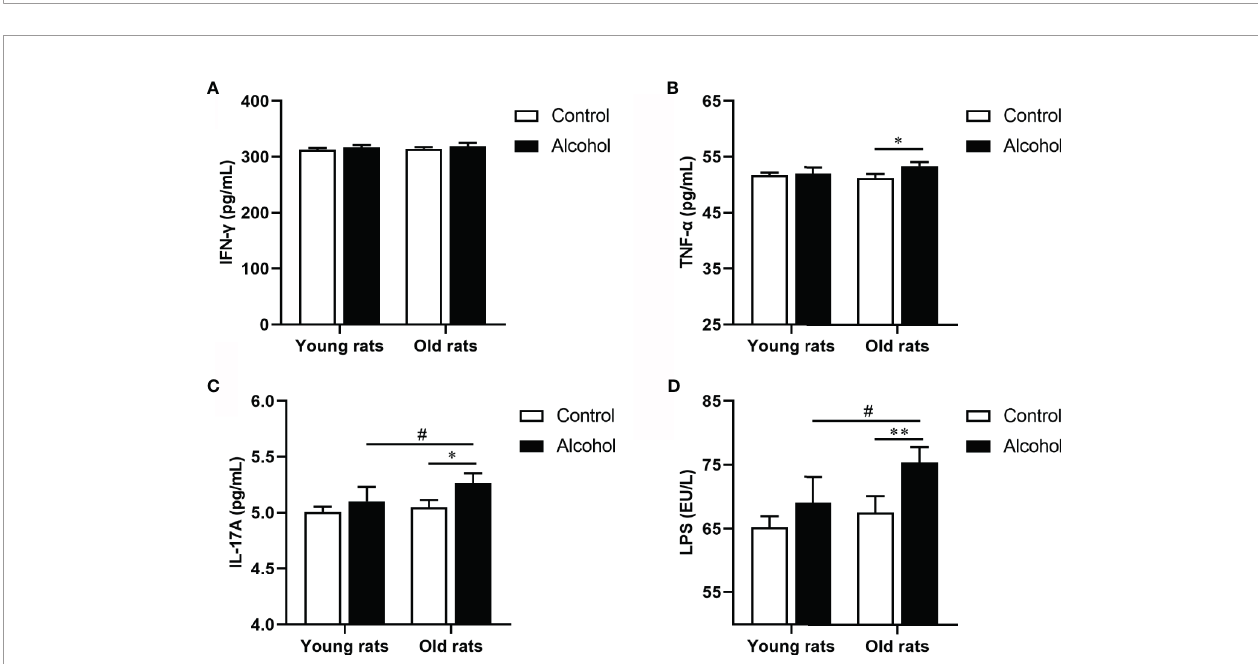
FIGURE 4 | Effects of alcohol on serum in fl ammatory cytokine in young and old rats. (A) The expression of IFN- g in serum; (B) The expression of TNF- a in serum; (C) The expression of IL-17A in serum; (D) The expression of LPS in serum. Data were shown as mean ± SD. n = 6, * P < 0.05, ** P < 0.01, compared with control of the same age; # P < 0.05, the same group compared with young rats.